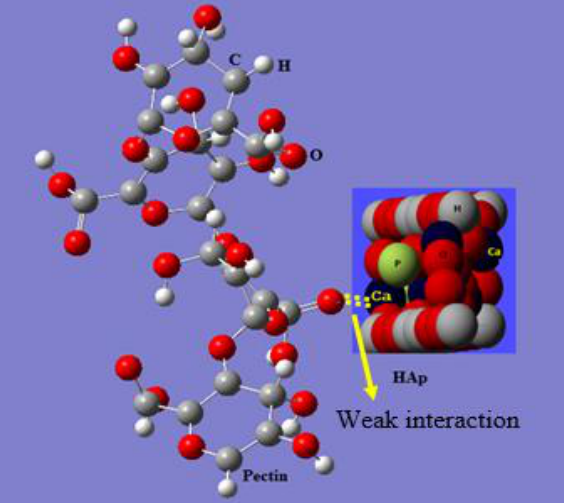
Figure 6. Schematic Model of the weak interaction between the CO-pectin and Ca-HAp.